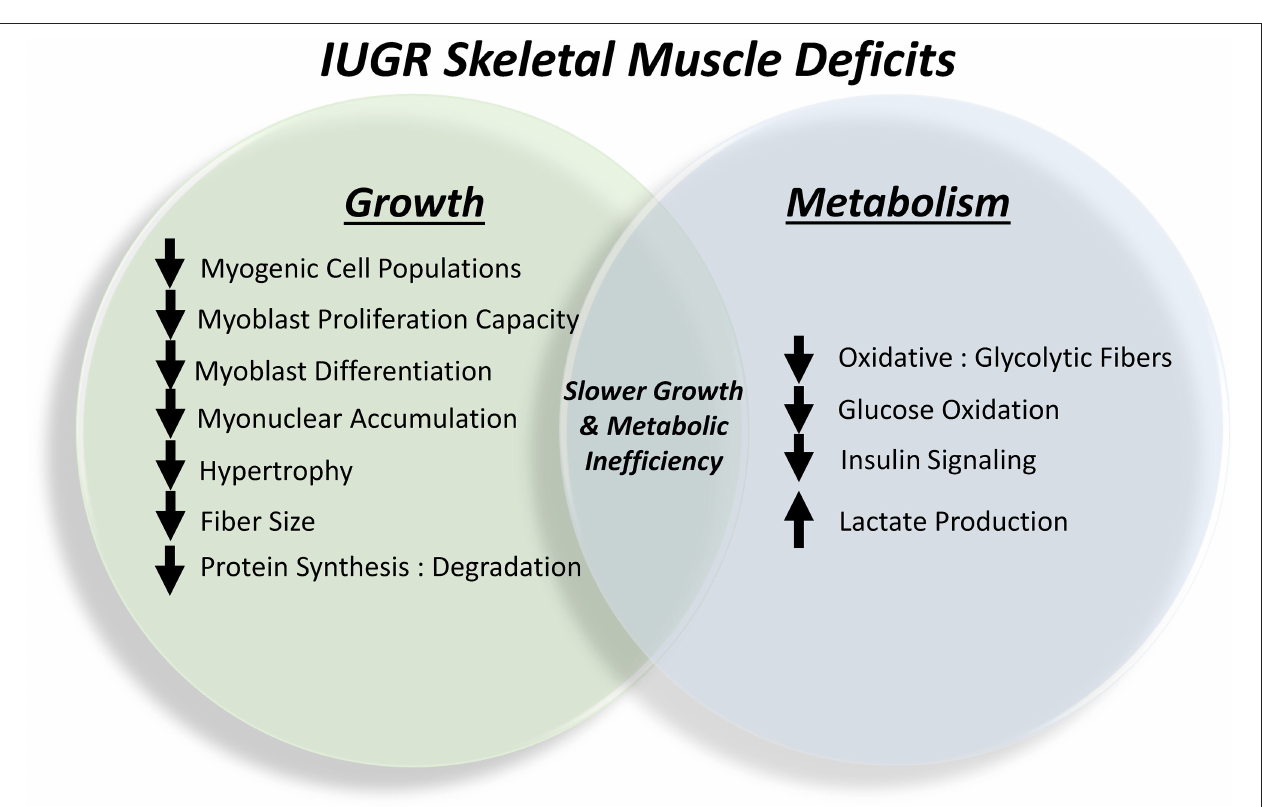
FIGURE 2 | Summary of the outcomes of skeletal muscle programming in the IUGR fetus that contribute to lifelong impairments in growth capacity and metabolic homeostasis.